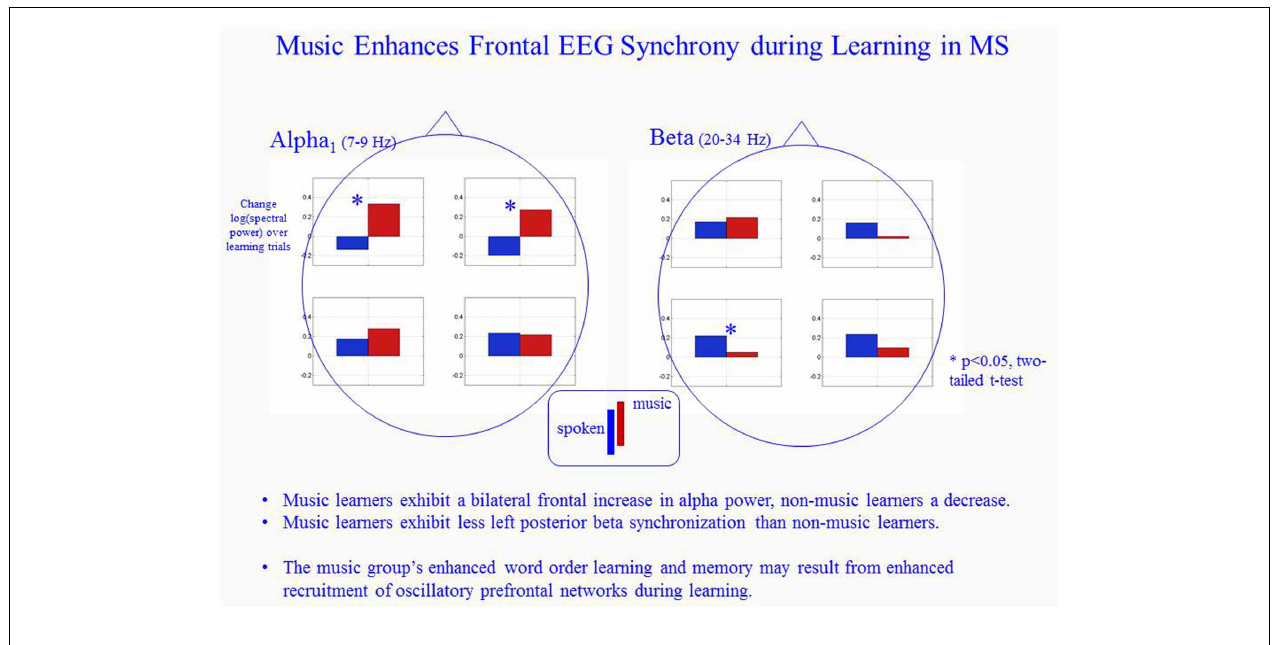
associated with significantly reduced left posterior beta LRS than conventional spoken verbal learning (*denotes statistically significant difference between the